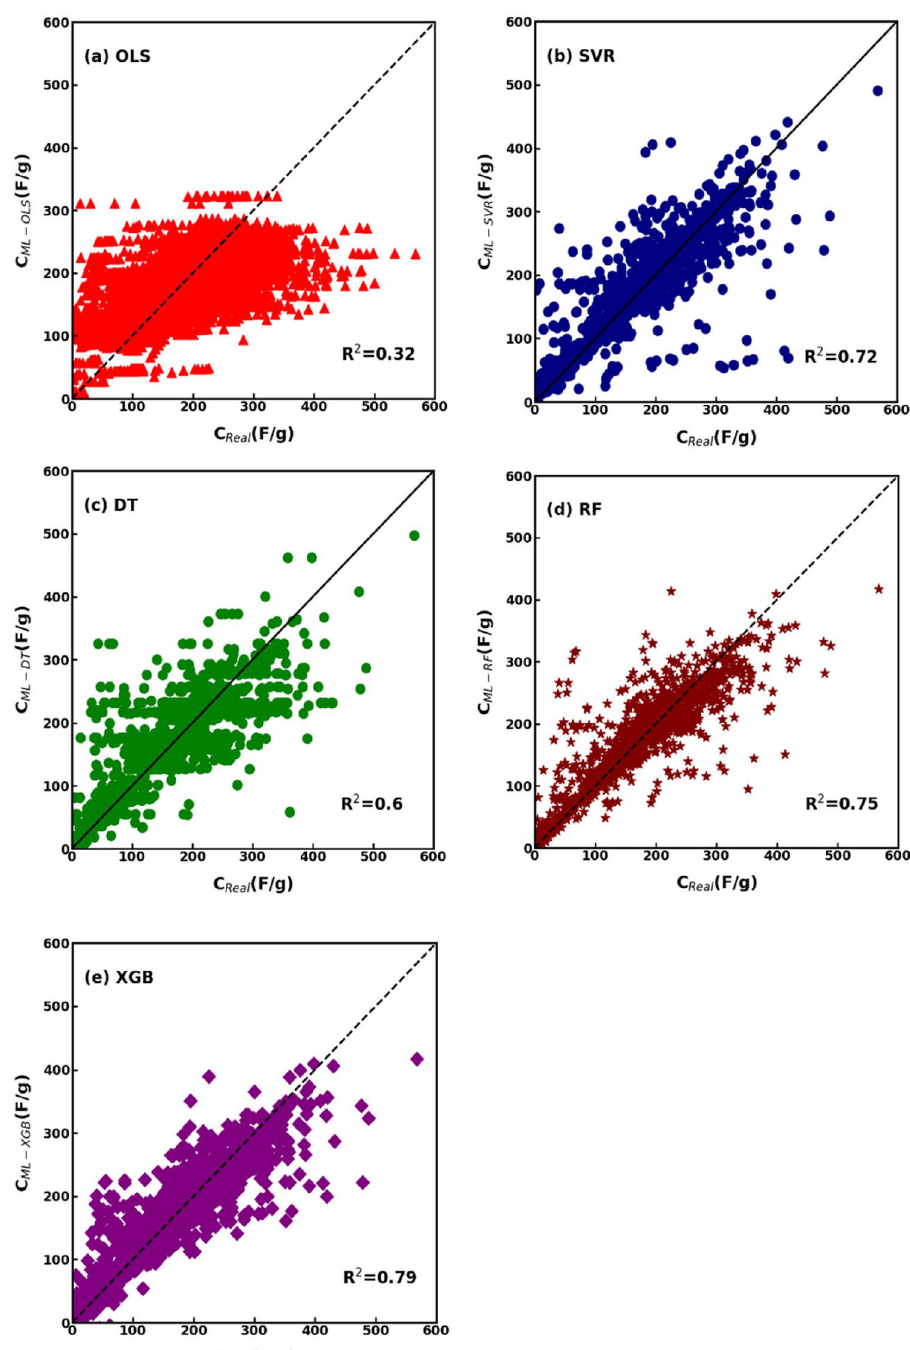
Figure 4. Comparison between the actual specific capacitance from literature research articles in the dataset and the predicted specific capacitance from ( a ) OLS, ( b ) SVR, ( c ) DT, ( d ) RF, and ( e ) XGBoost